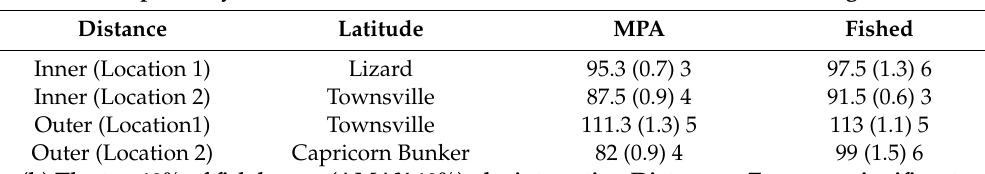
Table 5. The influence of marine protection from fishing on demographic characteristic of Acanthochromis polyacanthus . Summary statistics for both SL and age data are presented as mean (standard error; SE) range. Three-way partially hierarchical ANOVAs are presented for the factors distance (D), zone (Z), D × Z, location(distance) and location(distance × Z in Table S2 (Supplementary Materials); significant factors are listed here. Factor zone: treatments marine protected area (MPA) and fished. Details of von Bertalan ff y parameters by reef and zone are provided in Table S2 (Supplementary